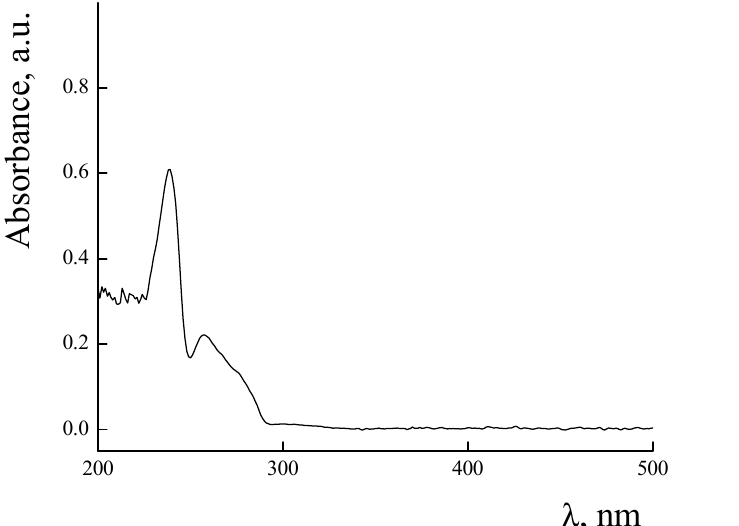
Figure 10. Absorbance spectra of Paclitaxel-Teva. Concentration of Paclitaxel-Teva 0.5 mg/mL, Tris buffer with pH 7, c = 0.01 M, 25 °C.